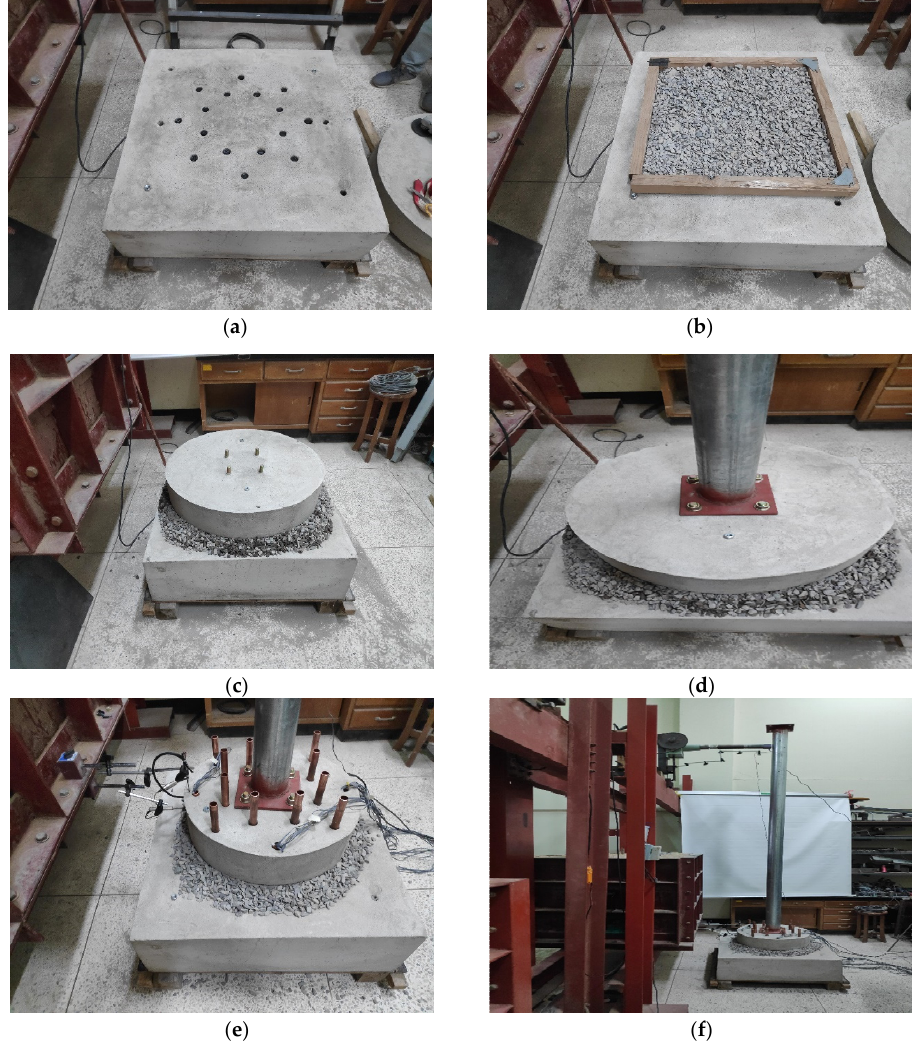
Figure 5. Procedure for the construction of the model: ( a ) base ground installation; ( b ) rubble mound layer laying; ( c ) wind turbine foundation installation (existing type); ( d ) wind turbine tower connection; ( e ) pile penetration (reinforced piles); ( f ) measuring instrument installation and experiment view.